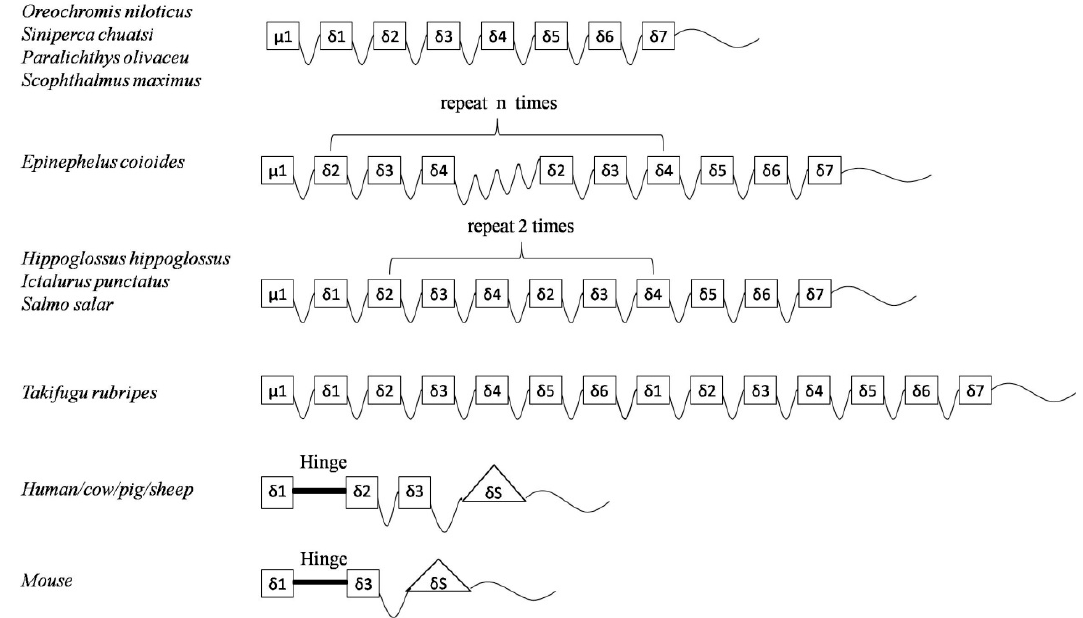
Figure 2. Structural schematic of the IgD constant region included in teleost, primates, rodents, and artiodactyls.